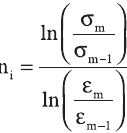
Figure 5. Relationship between instantaneous strain hardening exponent (n and % fractional theoretical density.